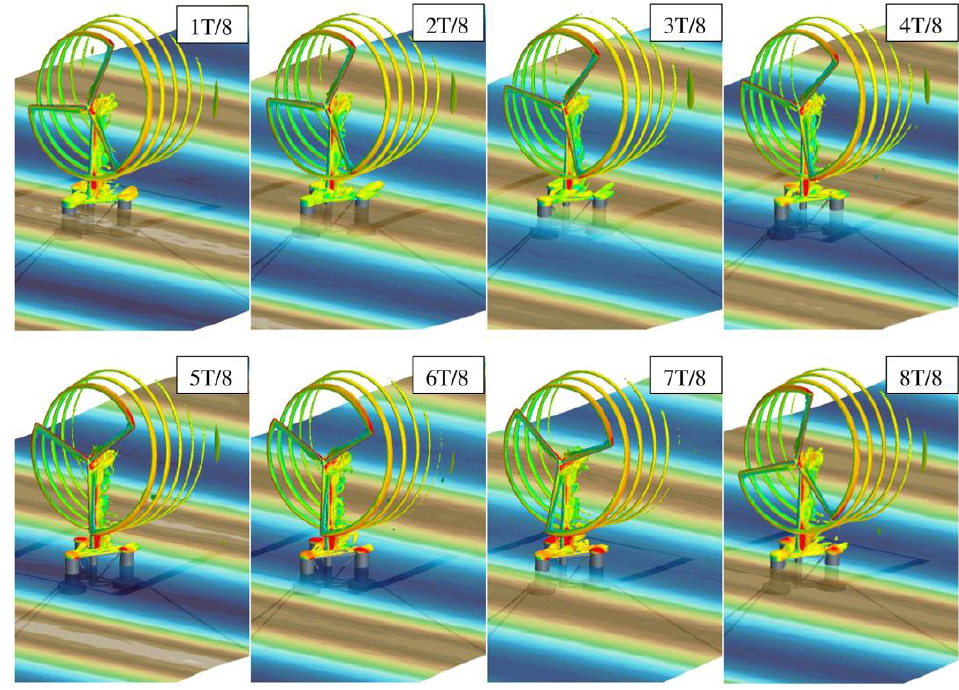
Figure 14. Instantaneous iso-vorticity contours for the semi-submersible FOWT with 6-DOF motions [142].